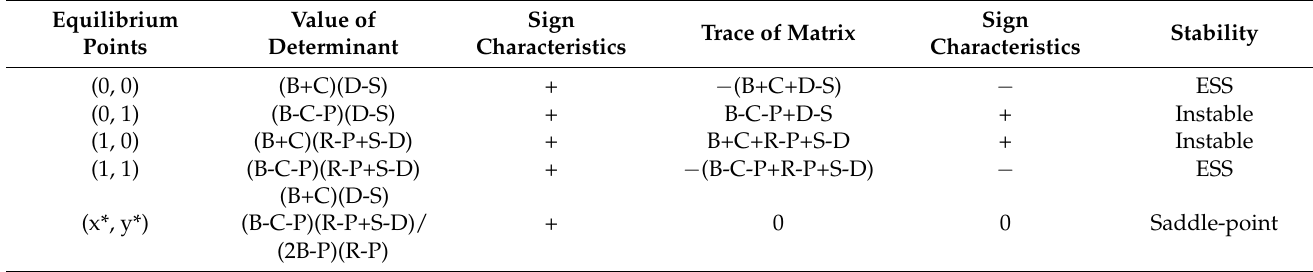
Table 2. Property of equilibrium